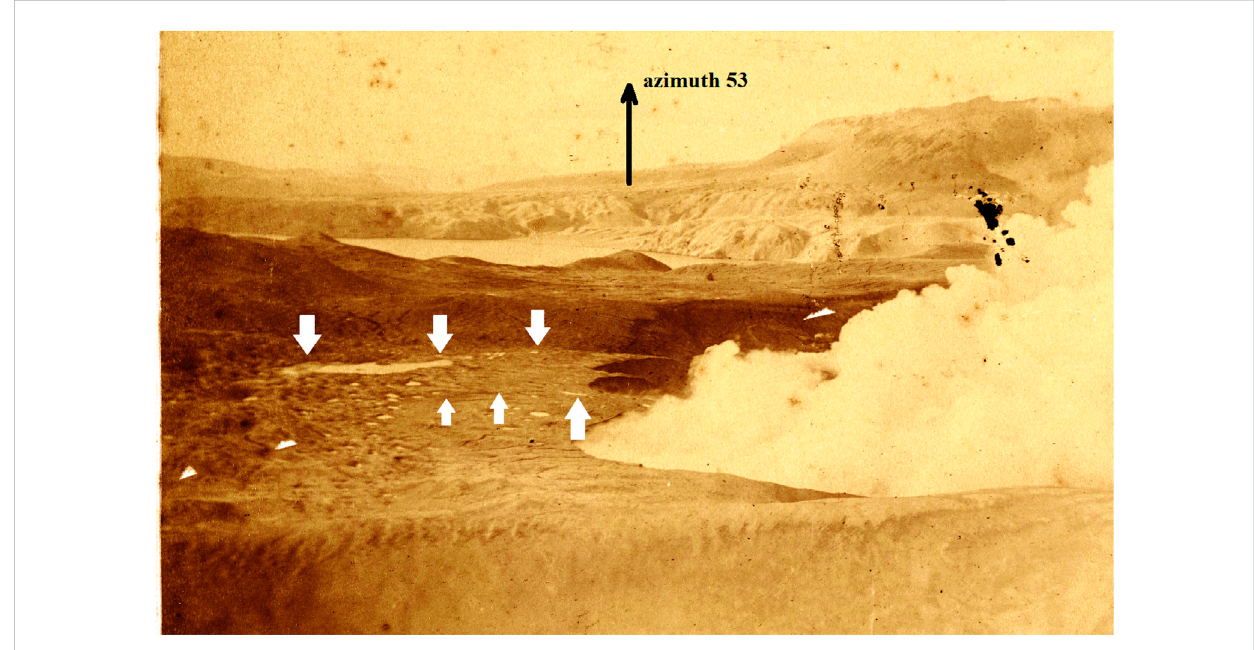
FIGURE 15 Spencer ’ s photograph (cropped) of the northwest crater in July 1886, looking northeast. Black Terrace Stream, surface water, and the runnel are arrowed (Te Papa MA_1396152) (image deterioration is likely from poor print fi